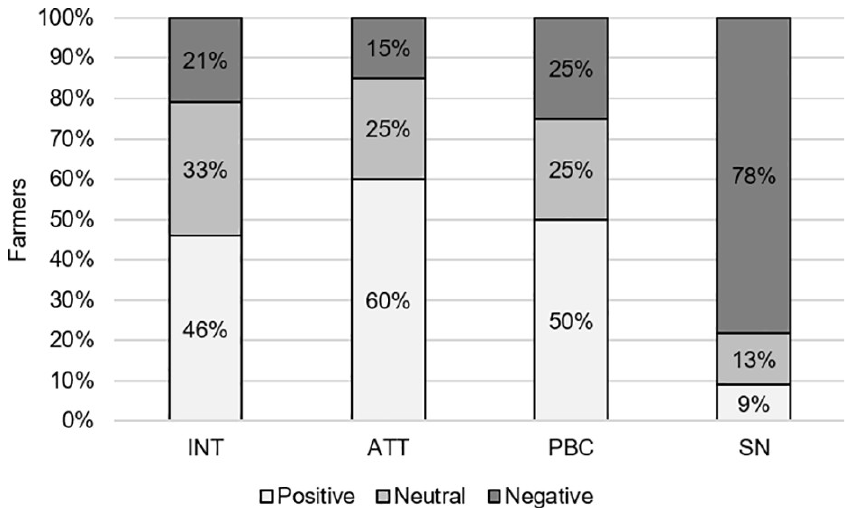
Fig 2. Intention (INT) of farmers towards adapting their Fusarium spp. management, and their underlying attitude (ATT), perceived behavioural control (PBC), and social norm (SN) (% negative, neutral, or